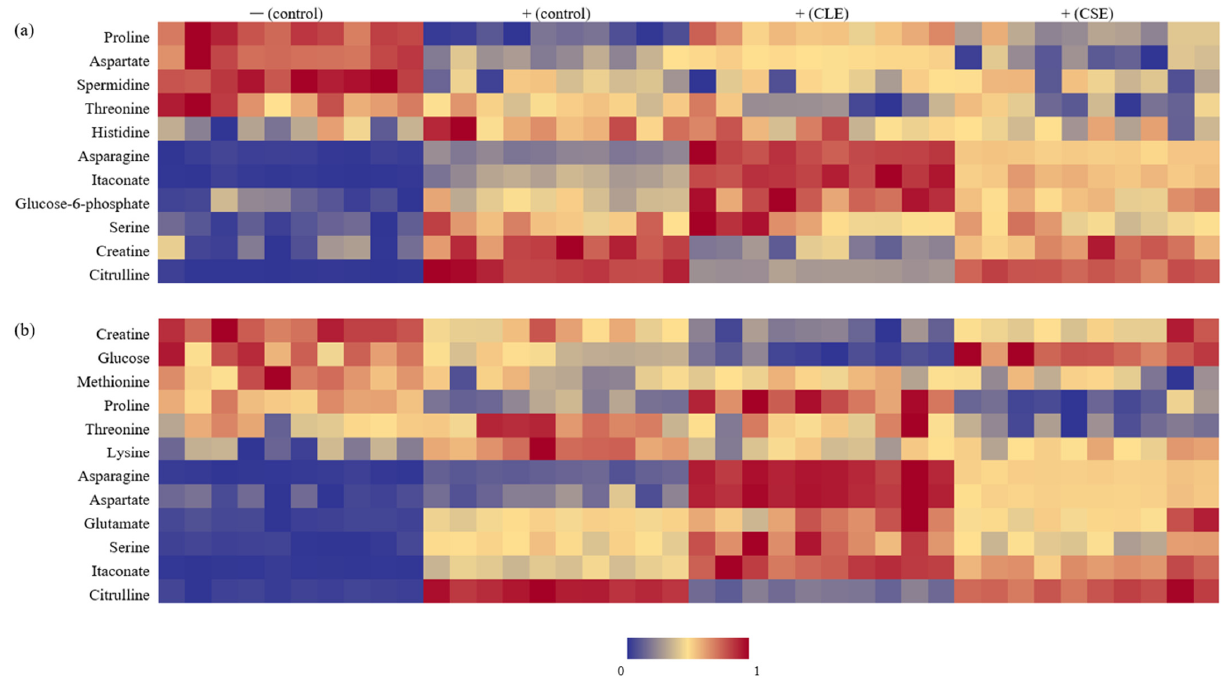
Figure 4. Heatmap visualization of significantly different metabolites ( p < 0.05) derived from LC-MS targeted analysis of cell extracts and culture medium from different treatment groups. (+) and ( − ) refer to LPS-stimulated and unstimulated cells respectively: ( a ) intracellular metabolites; ( b ) extracellular metabolites.